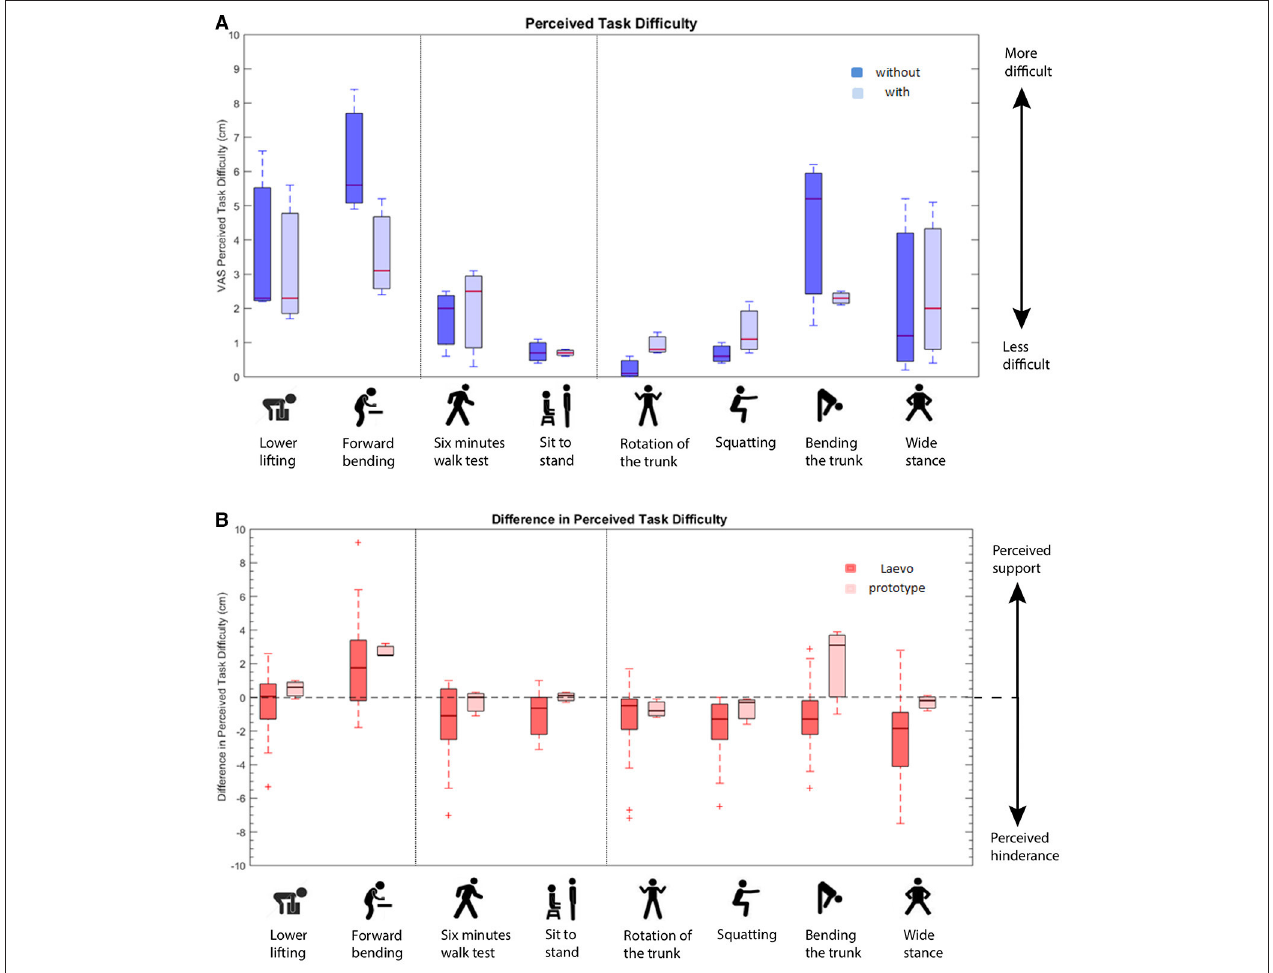
FIGURE 12 | (A) Boxplots of perceived task difficulty. The red line represents the sample median. The distances between the tops and bottoms are the interquartile ranges. Whiskers show the min and max values; The dotted lines represent the division between (1) tasks to assess the supportive function of the device (right side), (2) tasks to assess the extent of restricted hip flexion (middle), and (3) tasks to asses the ROM (right side); 0 = very easy, 10 = very difficult. (B) Comparison of the Laevo device assessed in Baltrusch et al. (2017) and the prototype of the current study: Boxplots of difference in perceived task difficulty between without and with exoskeleton condition. Values above the dashed zero baseline indicate a support by the device, values below the baseline indicate a hindrance by the device. The red line represents the sample median. The distances between the tops and bottoms are the interquartile ranges. Whiskers show the min and max values; The dotted lines represent the division between 1) tasks to assess the supportive function of the device (right side), 2) tasks to assess the extent of restricted hip flexion (middle), and 3) tasks to asses the ROM (right